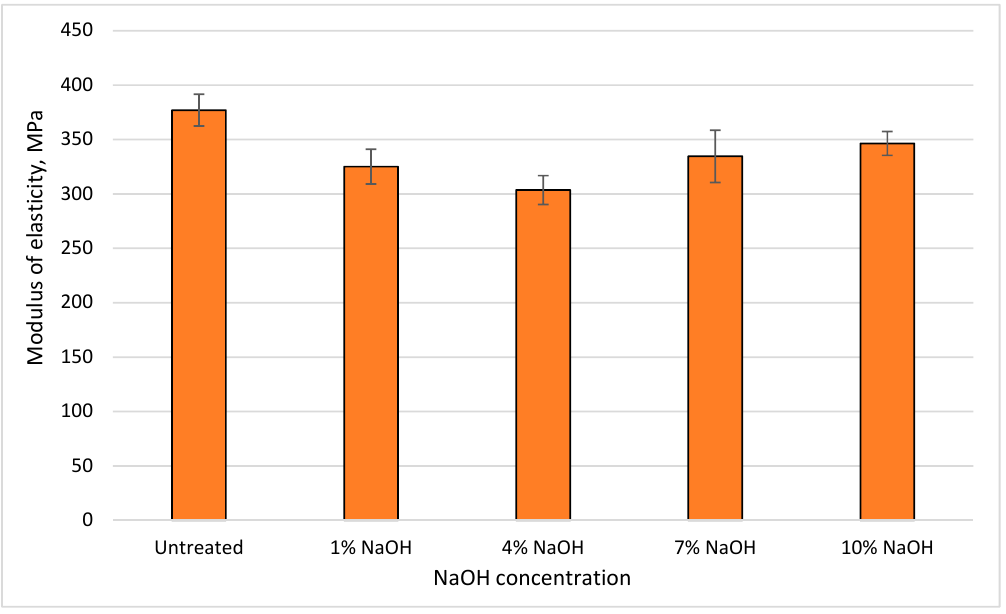
Figure 13. Modulus of elasticity of the rubber polyester composites.